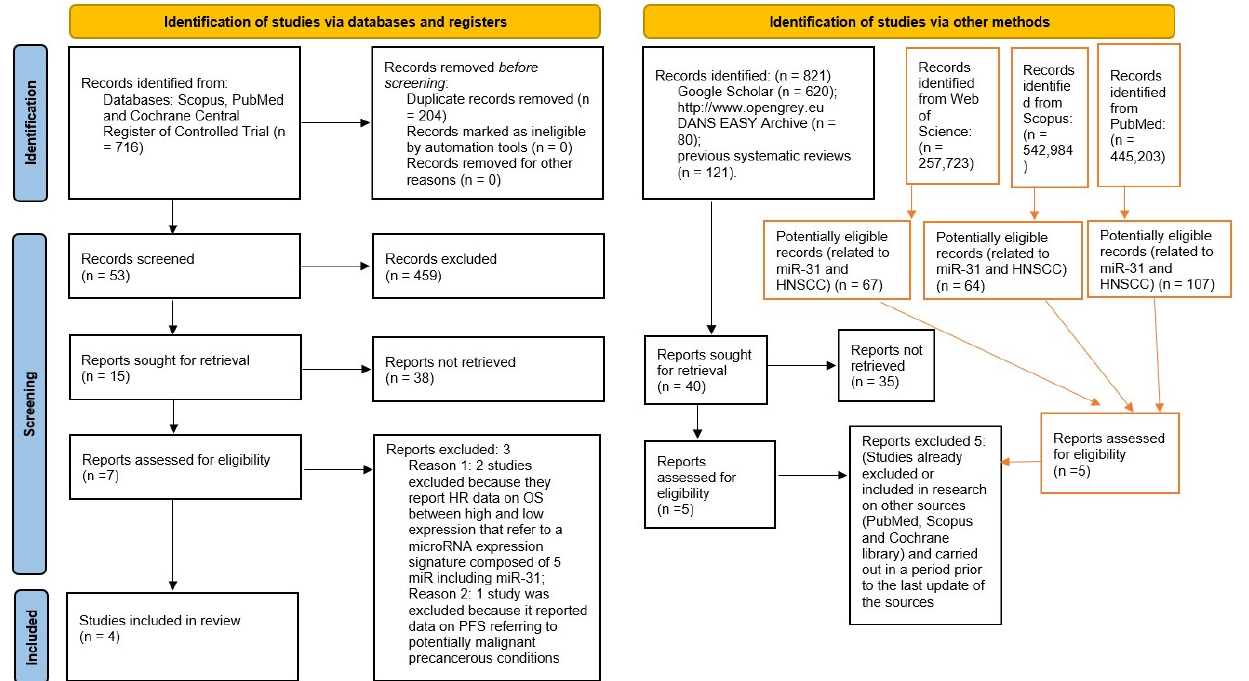
Figure 1. Entire selection and screening procedures are described in the PRISMA flowchart; tables with the red lines are the searches performed subsequently (on 3 March 2022), with the addition of Web of Science and with an update of the keywords and results on PubMed and Scopus. Table 1. Complete overview of the search methodology. In total, 716 records were identified by the databases (512 records after removal of duplicates); Records identified by other research sources: 721 records.